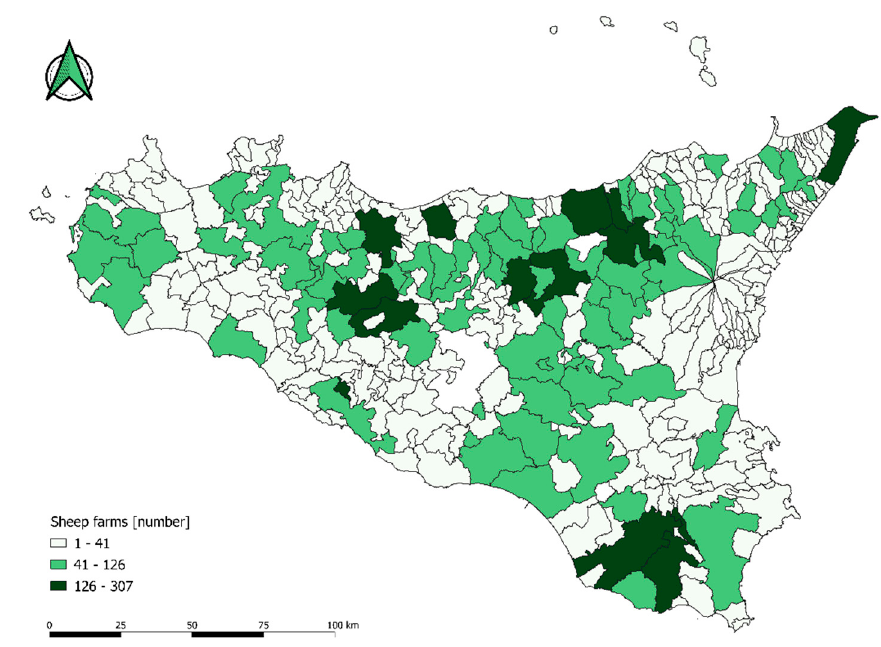
Figure 6. Sheep farm concentration at municipal level.